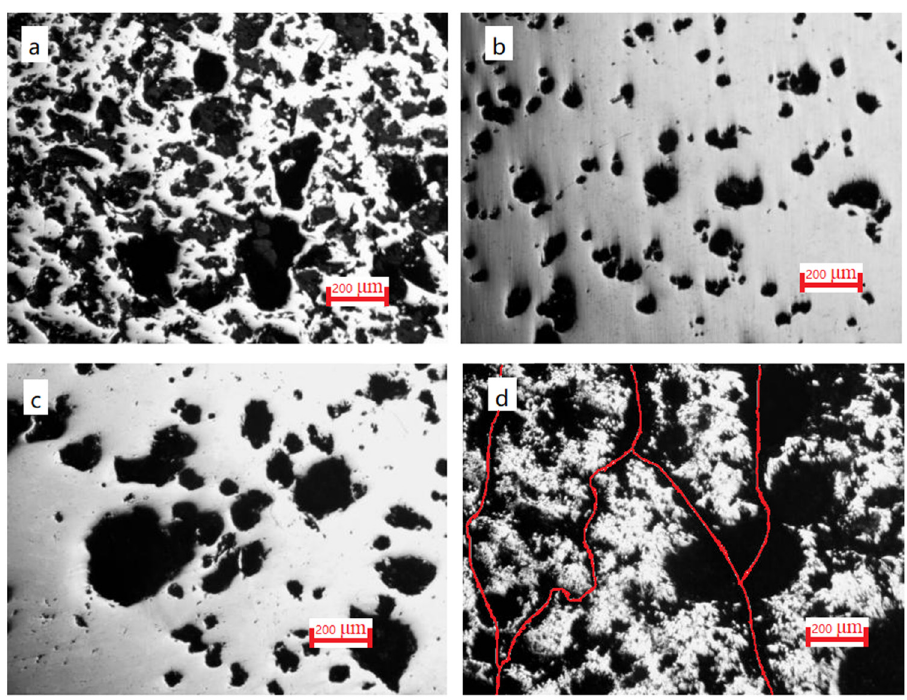
Figure 5: Optical microscope images of polished specimens with different Co/Al molar ratios: ( a ) 1:1, ( b ) 1:3, ( c ) 4:13, and ( d )